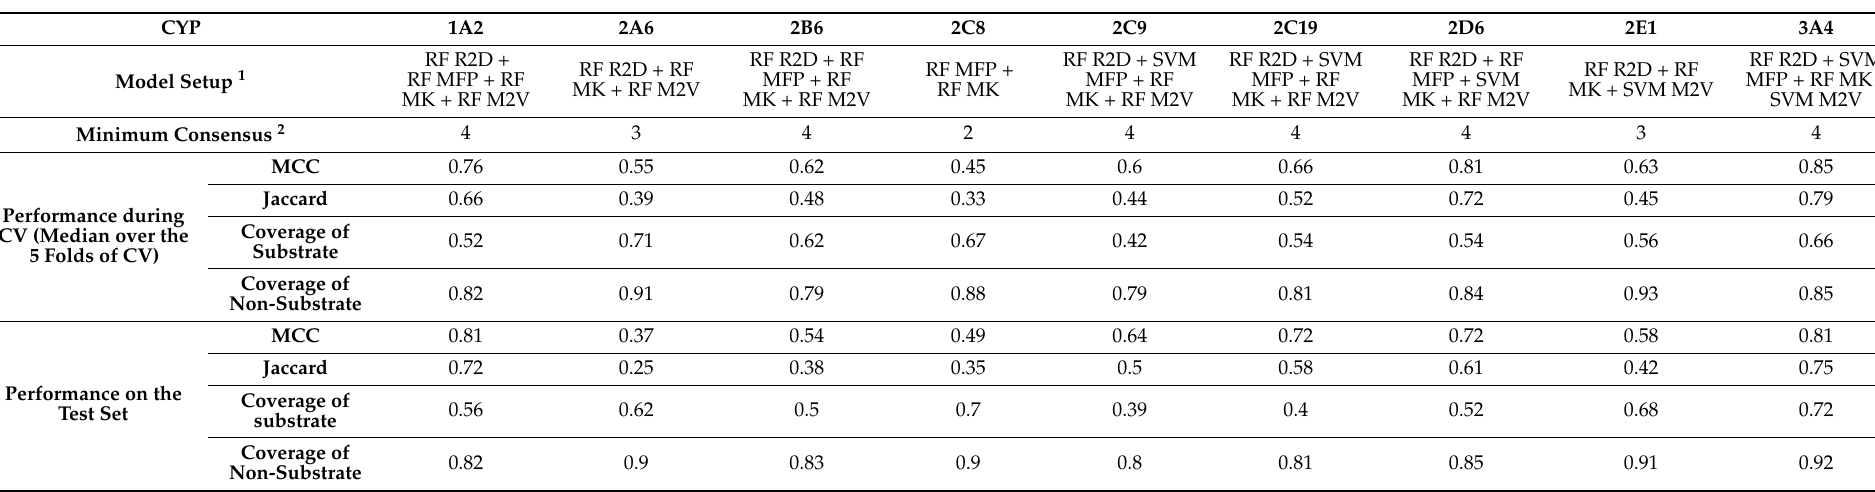
Table 5. Performance of the best-performing hard voting classifiers by